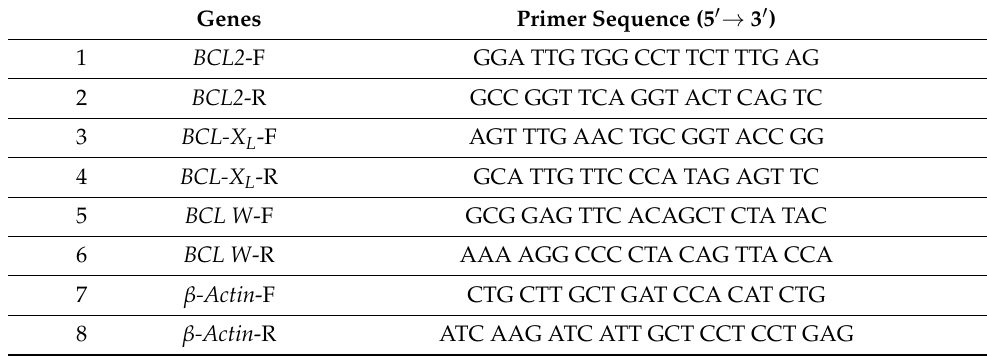
Table 2. Primer sequences of transcripts evaluated in the study.